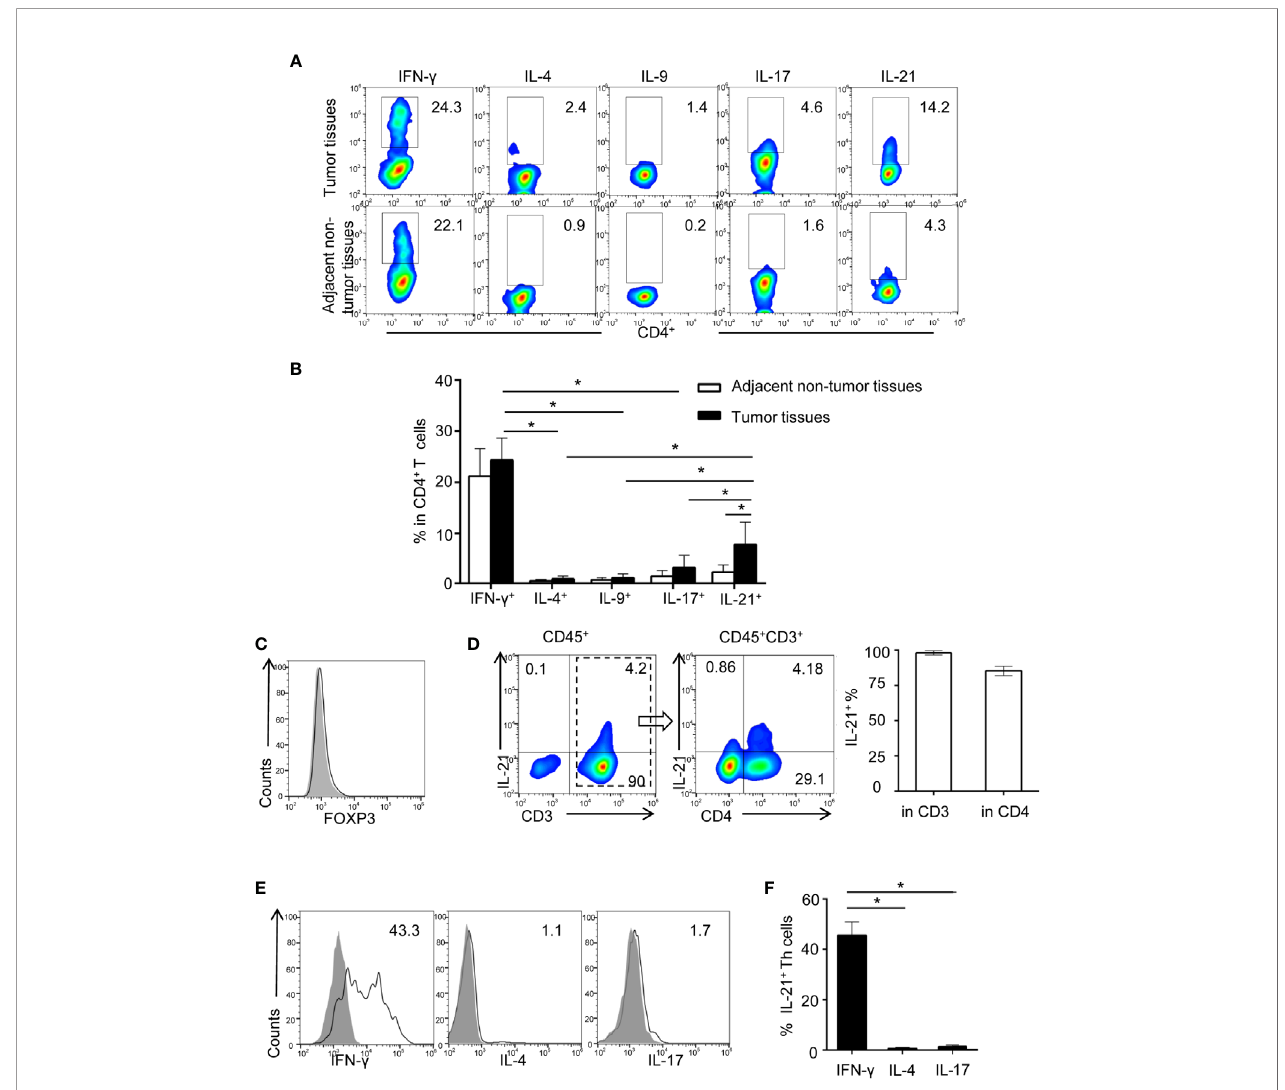
FIGURE 1 | Identi fi cation of increasing tumor-in fi ltrating IL-21 producing Th cells in HNSCC. (A) Representative fl ow cytometric plots of Th subsets isolated from tumor and adjacent non-tumor tissues. (B) Quanti fi cation of proportions of Th subsets (mean ± SD, n = 9, *P < 0.05 by Student ’ s t test). (C, D) Flow cytometric analysis of IL-21 frequency in gated CD45 + cells and CD45 + CD3 + cells in tumor in fi ltrating lymphocytes. (E, F) Expression pro fi le of IFN- g , IL-4, and IL-17 in IL-21 + Th cells from HNSCC tumor tissues, n = 5. Gating strategy was provided in Supplementary Figure 1